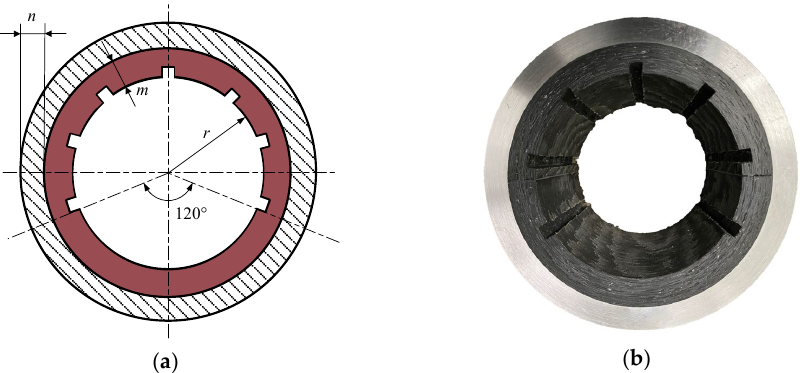
Figure 8. Test bearings. ( a ) structural diagram of the bearing, ( b ) solid Diagram of the bearing. Table 2. Basic parameters of each item of equipment.